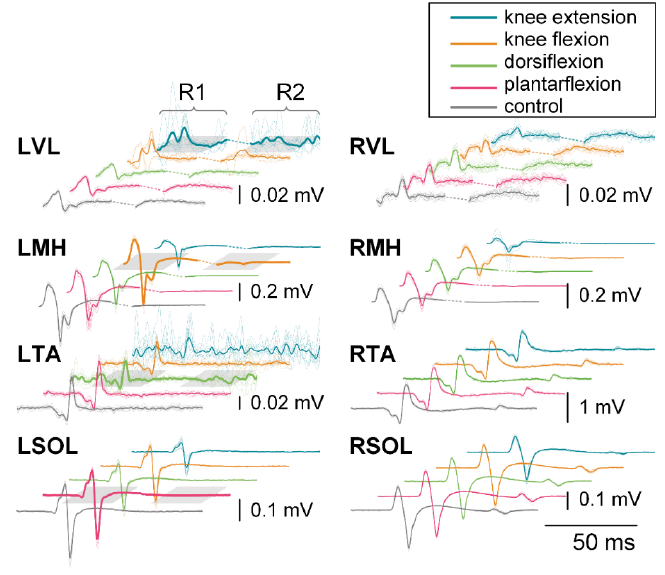
Figure 6. R1 and R2 responses for each muscle during knee extension (blue), knee flexion (orange), dorsiflexion (green), plantarflexion (pink), and control (gray) during the isometric contraction condition for a representative participant. Individual responses are traces that are represented with a thin dotted line, while the average is shown with a thin solid line. The bold line signifies the agonist for that movement. Different scales are used for each muscle to better visualize the waveforms.